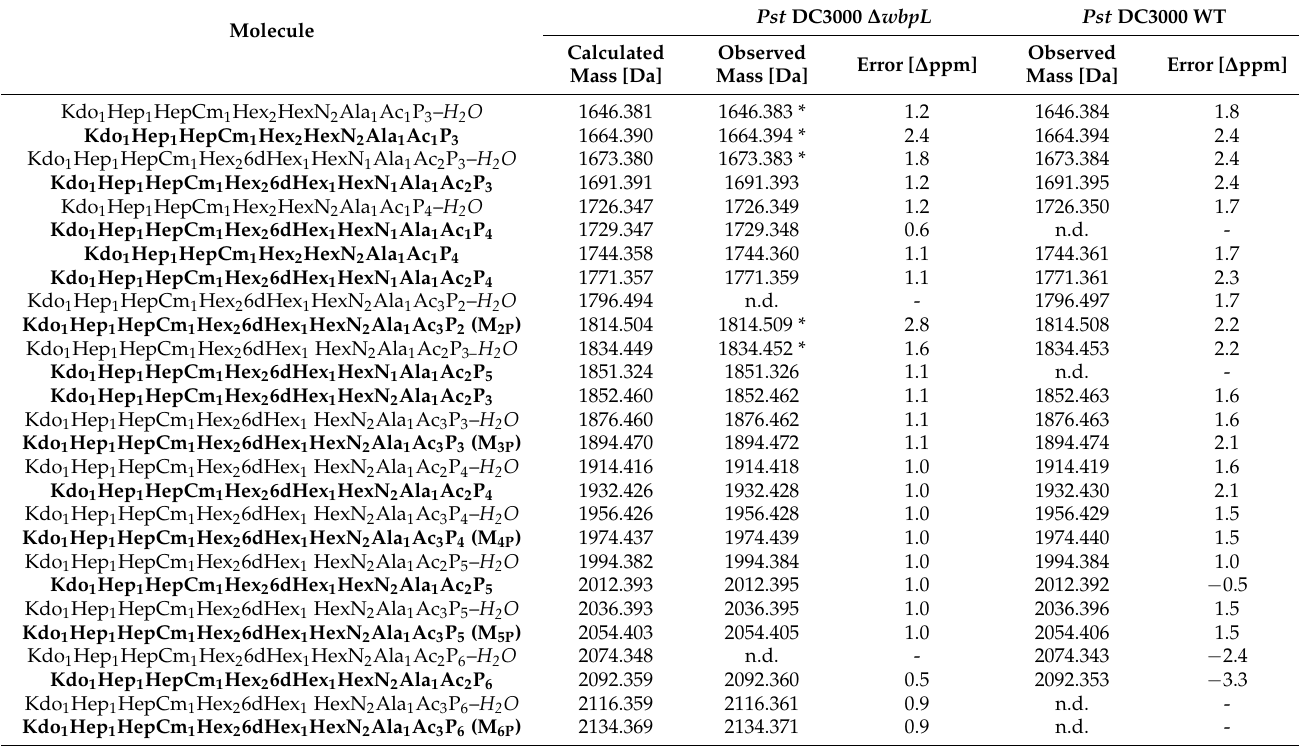
Table 6. Mass spectrometric analysis of core-OS of Pst DC3000 ∆ wbpL and wild type. Summary of calculated and observed monoisotopic neutral masses [Da] is given. Accuracy of the measurement is stated as ∆ ppm; n.d. = not detected; * detected, but only with <5% of relative intensity to the major base